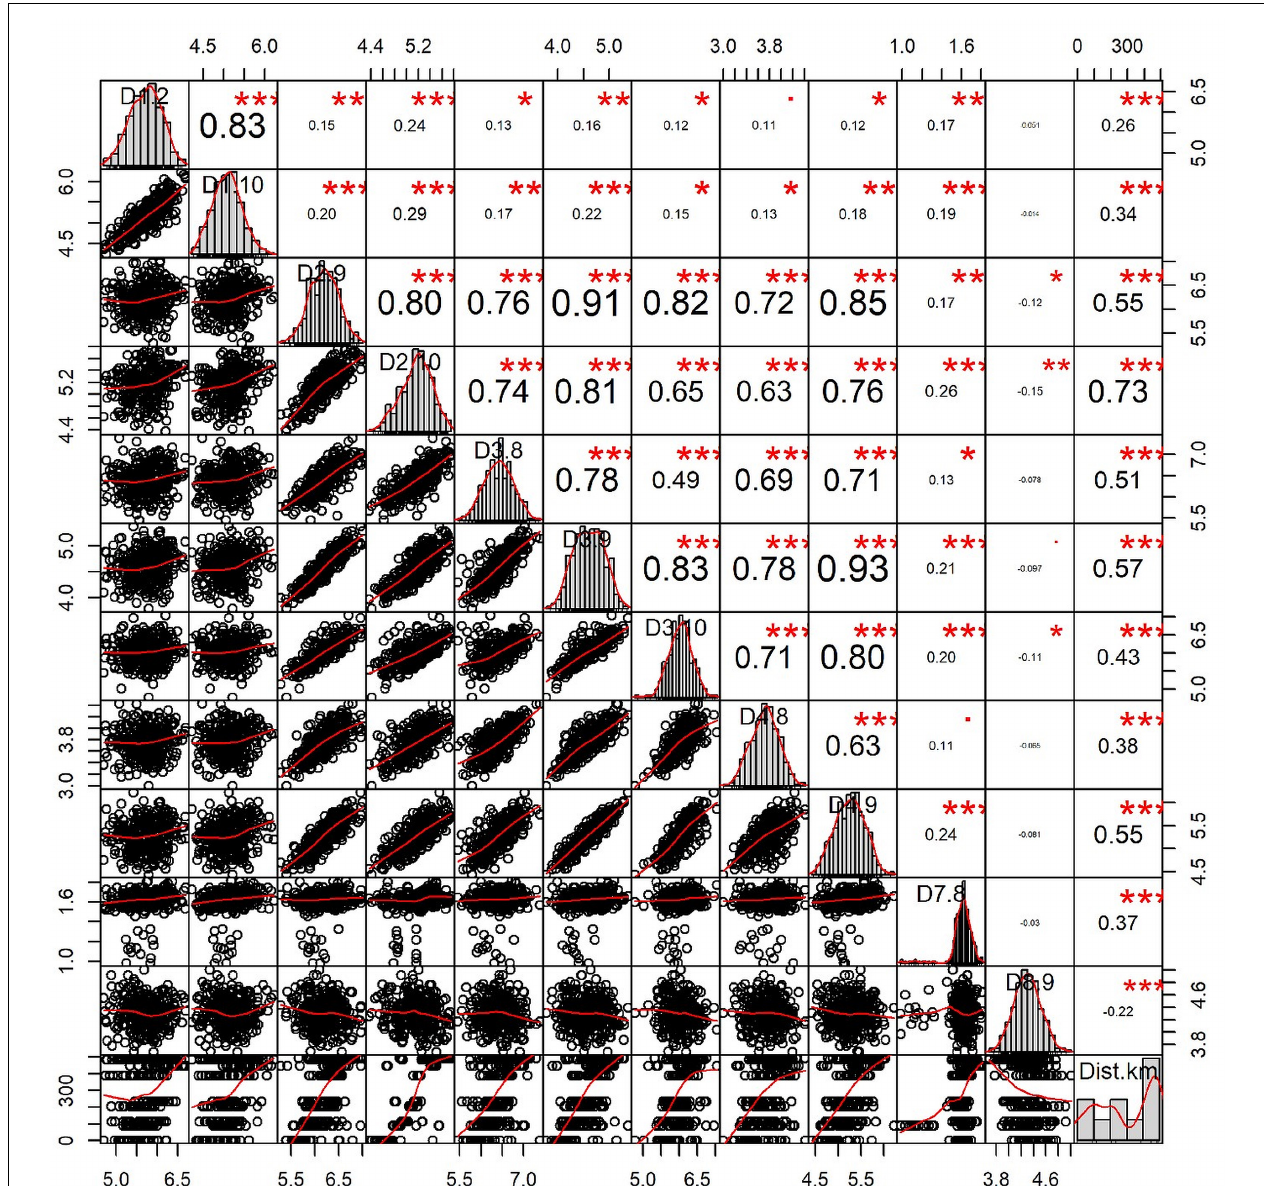
FIGURE 6 | The correlation plot among the geographic distances of collection sites from the deep sea and morphometric distances of Hilsa shad Tenualosa ilisha collected from heterogeneous habitats including the sea, estuary and different rivers. The values given around all the axes are the range of each individual parameter’s measured unit values (cm). Correlation coefficients (r) are indicated with numeric values, while significance levels (p) are denoted by asterisks (* < 0.05, ** < 0.01, *** <